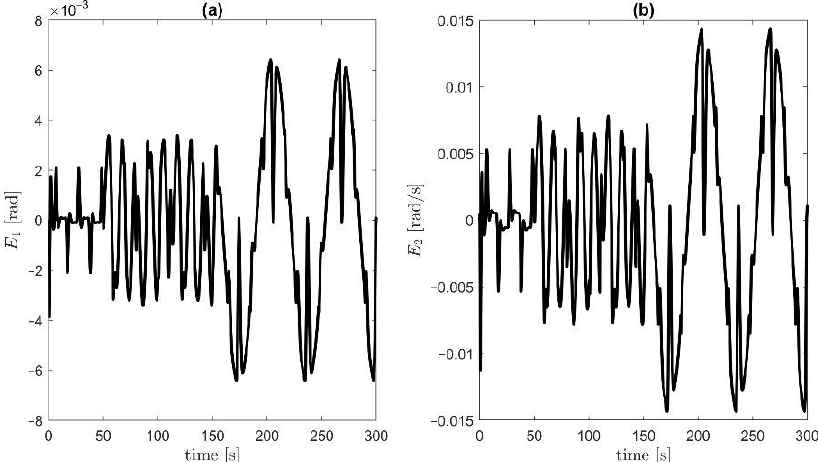
Figure 17. ( a ) Tracking error 𝐸 1 , ( b ) tracking error 𝐸 2 .